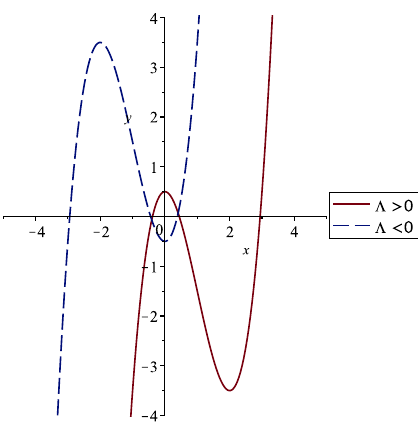
Figure 1 . The graphs show the zeroes of the polynomial F ( x ) with the positive discriminant, Q 2 < λ 2 , corresponding to the solutions for horizon radius x = v 2 > 0 of the three-dimensional space Σ . When Λ > 0 (continuous line), there are two solutions. When Λ < 0 (dashed line), there k is only one solution. The number of the solutions does not depend of the values of the parameters; the graphs are drawn for Q = 1 and Λ = ± 2